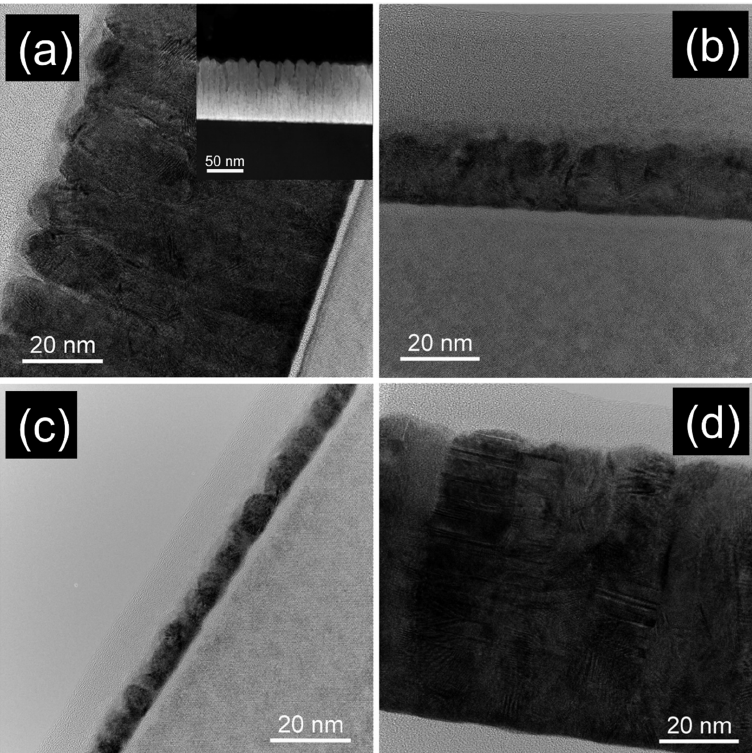
Figure 1. TEM micrographs of sample ( a ) Au 70 Fe 30 _70, ( b ) Au 70 Fe 30 _17, ( c ) Au 70 Fe 30 _6, and ( d ) Au 80 Fe 20 _70; the inset from ( a ) contains the STEM-DF image of sample Au 70 Fe 30 _70.